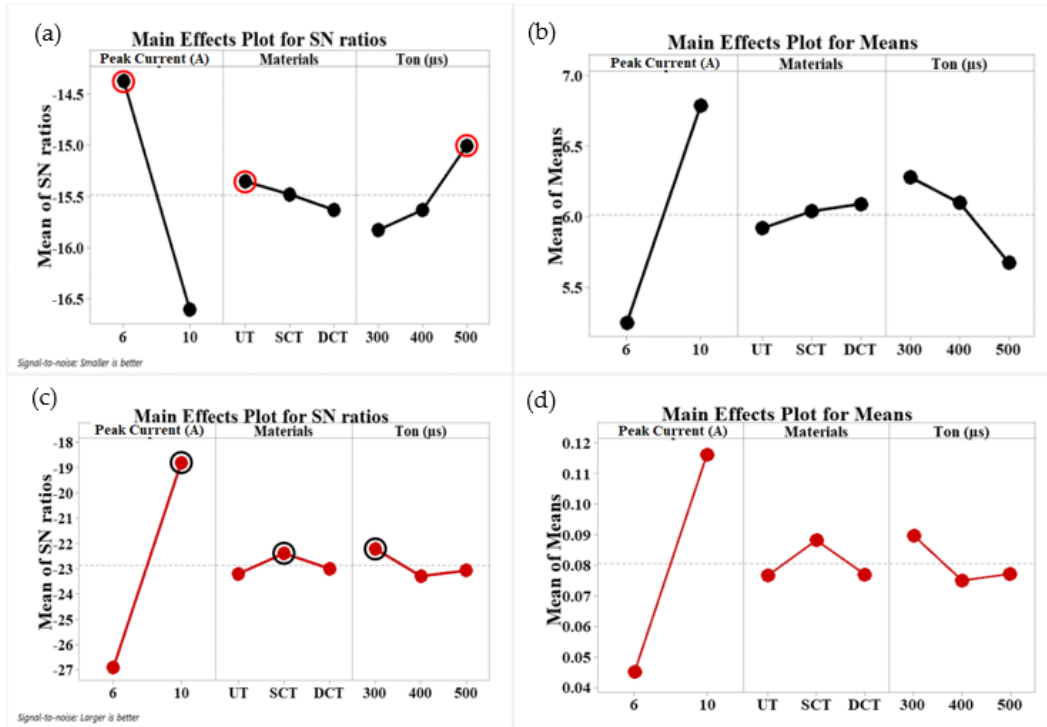
Figure 10. Main effects plot and S/N ratio for ( a , b ) average surface roughness and ( c , d ) MRR.